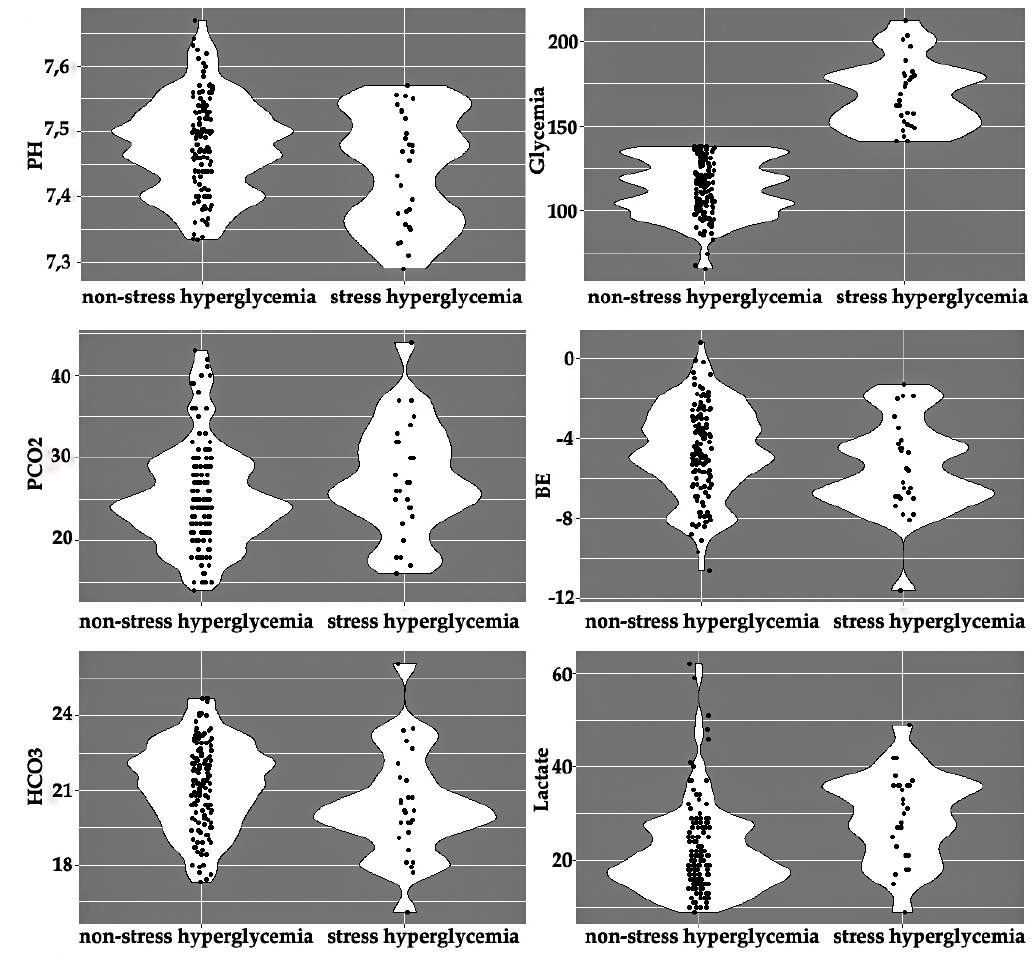
Figure A2. Acid–base status, glycemia, and lactic acid levels in the stress and non-stress hyperglycemia group (pH-logarithm of hydrogen ions concentration, glycemia-mg / dl, lactate-mg / dl, pCO 2 -mmHg, HCO 3 -mmol/l, BE-mmol/l).